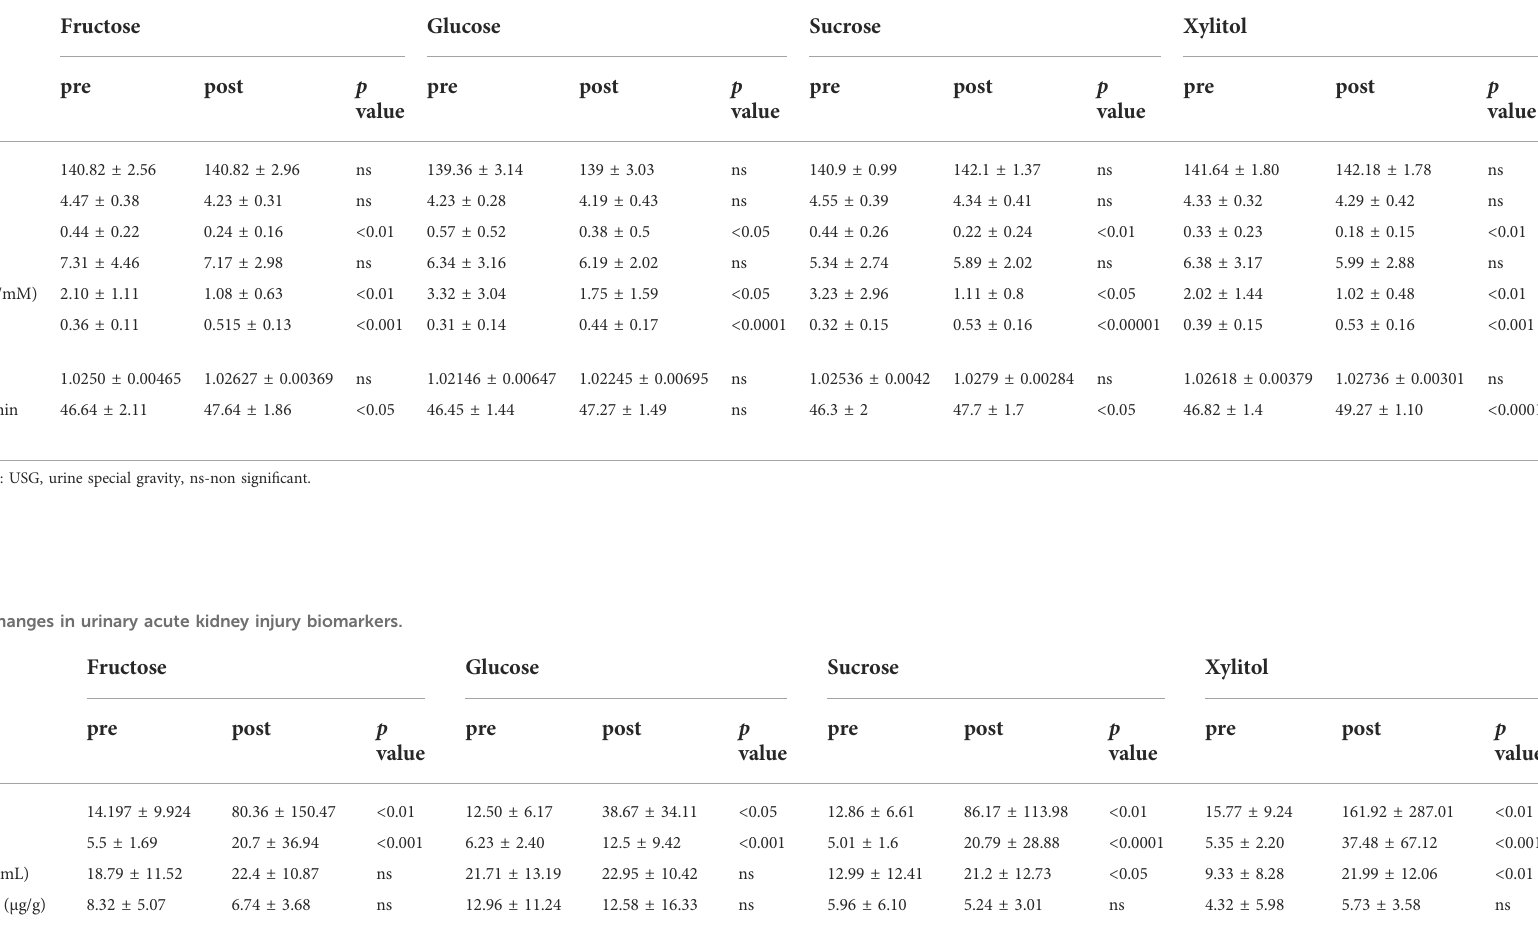
TABLE 7 Changes in markers of renal blood fl ow and dehydration.